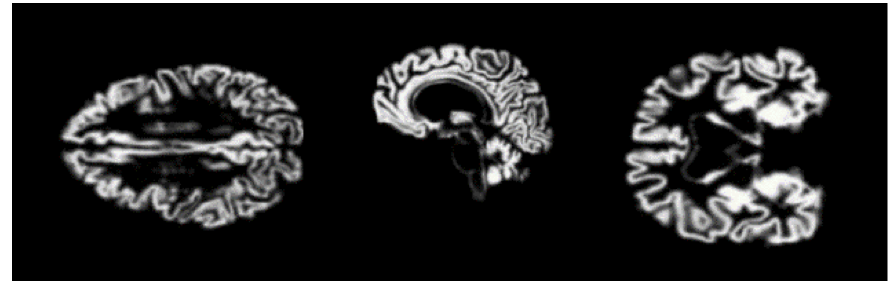
Figure 11. Gray matter images for proposed